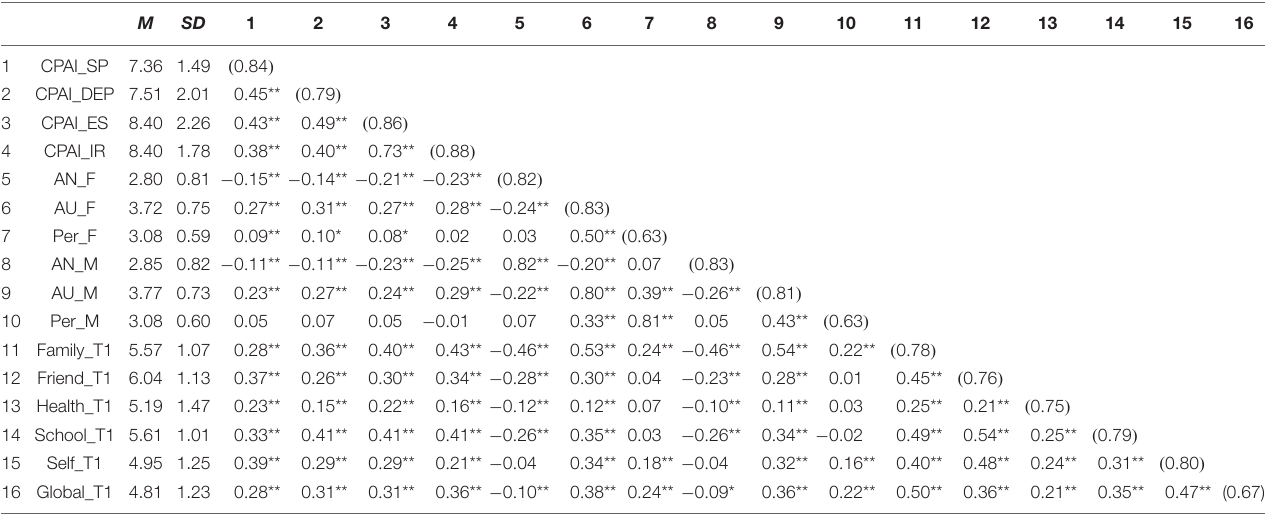
TABLE 1 | Descriptive statistics and zero-order correlations among personality, parenting styles, and life satisfaction at Time 1.